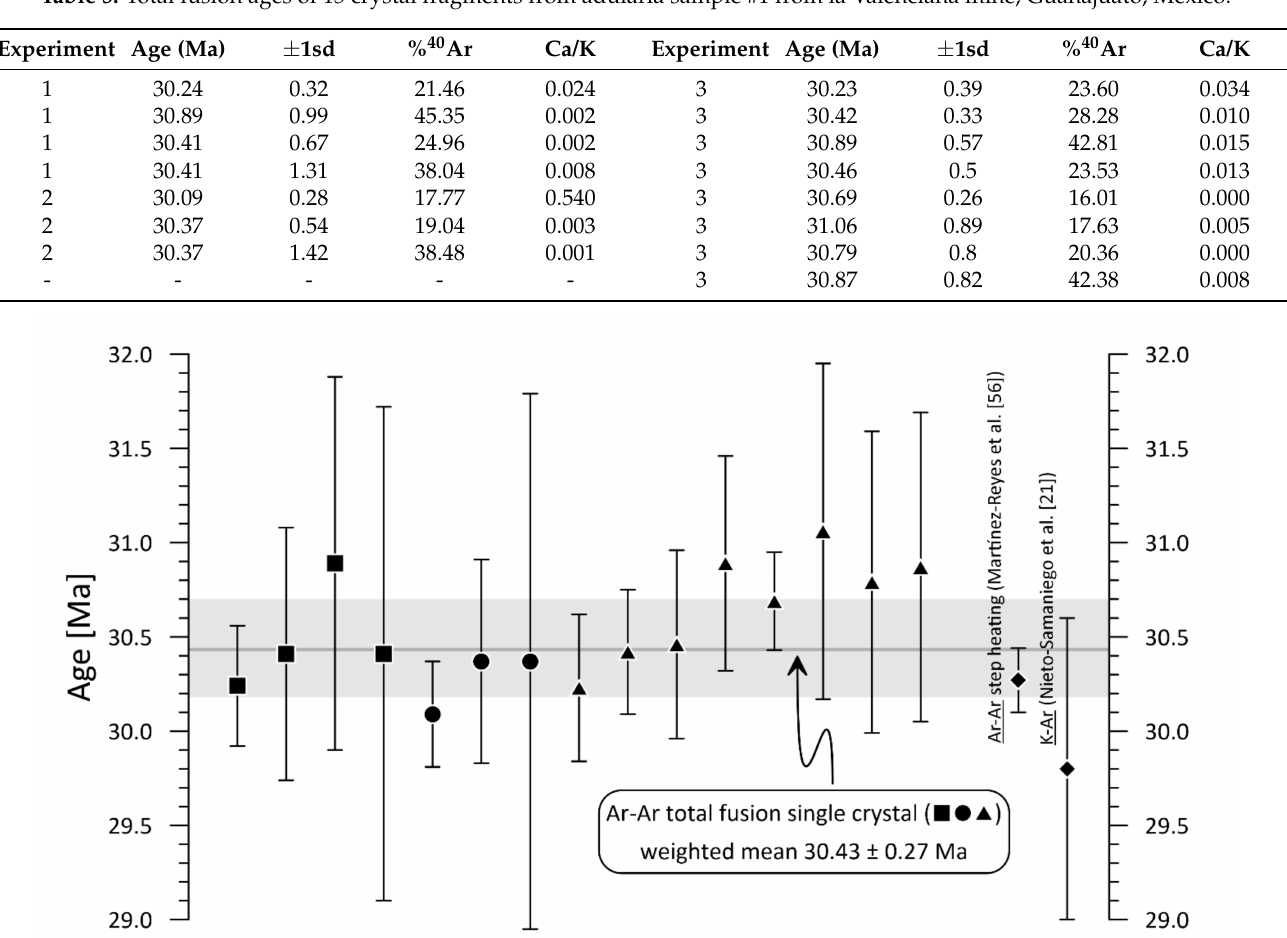
Table 5. Total fusion ages of 15 crystal fragments from adularia sample #1 from la Valenciana mine, Guanajuato, Mexico.